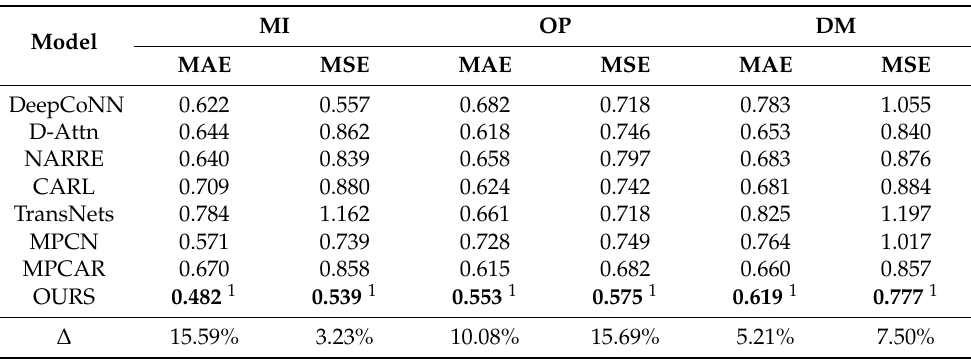
Table 3. Comparison of evaluation for different